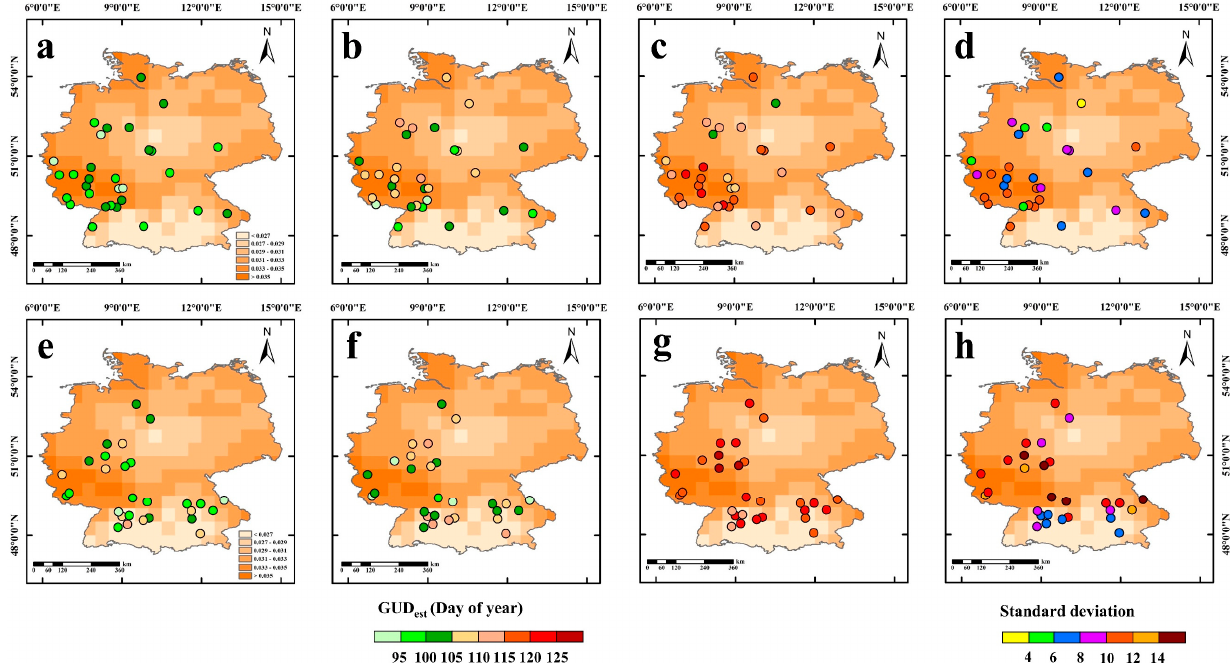
Figure 6. The spatial distribution of the multi-year average estimated green-up dates (GUD est ) of three methods (0.5-threshold-based method, Maximum-ratio-based methods, and Maximum-derivative-based (MDB) method) for forest-herbage-mixed (FHM) sites with GUD obs-forest < GUD obs-herbage ( a – c ) and with GUD obs-herbage < GUD obs-forest ( e – g ), ( d , h ) show the standard deviation of three methods. Gradients in the base map indicated the increasing trend of annual mean temperature from 1982 to